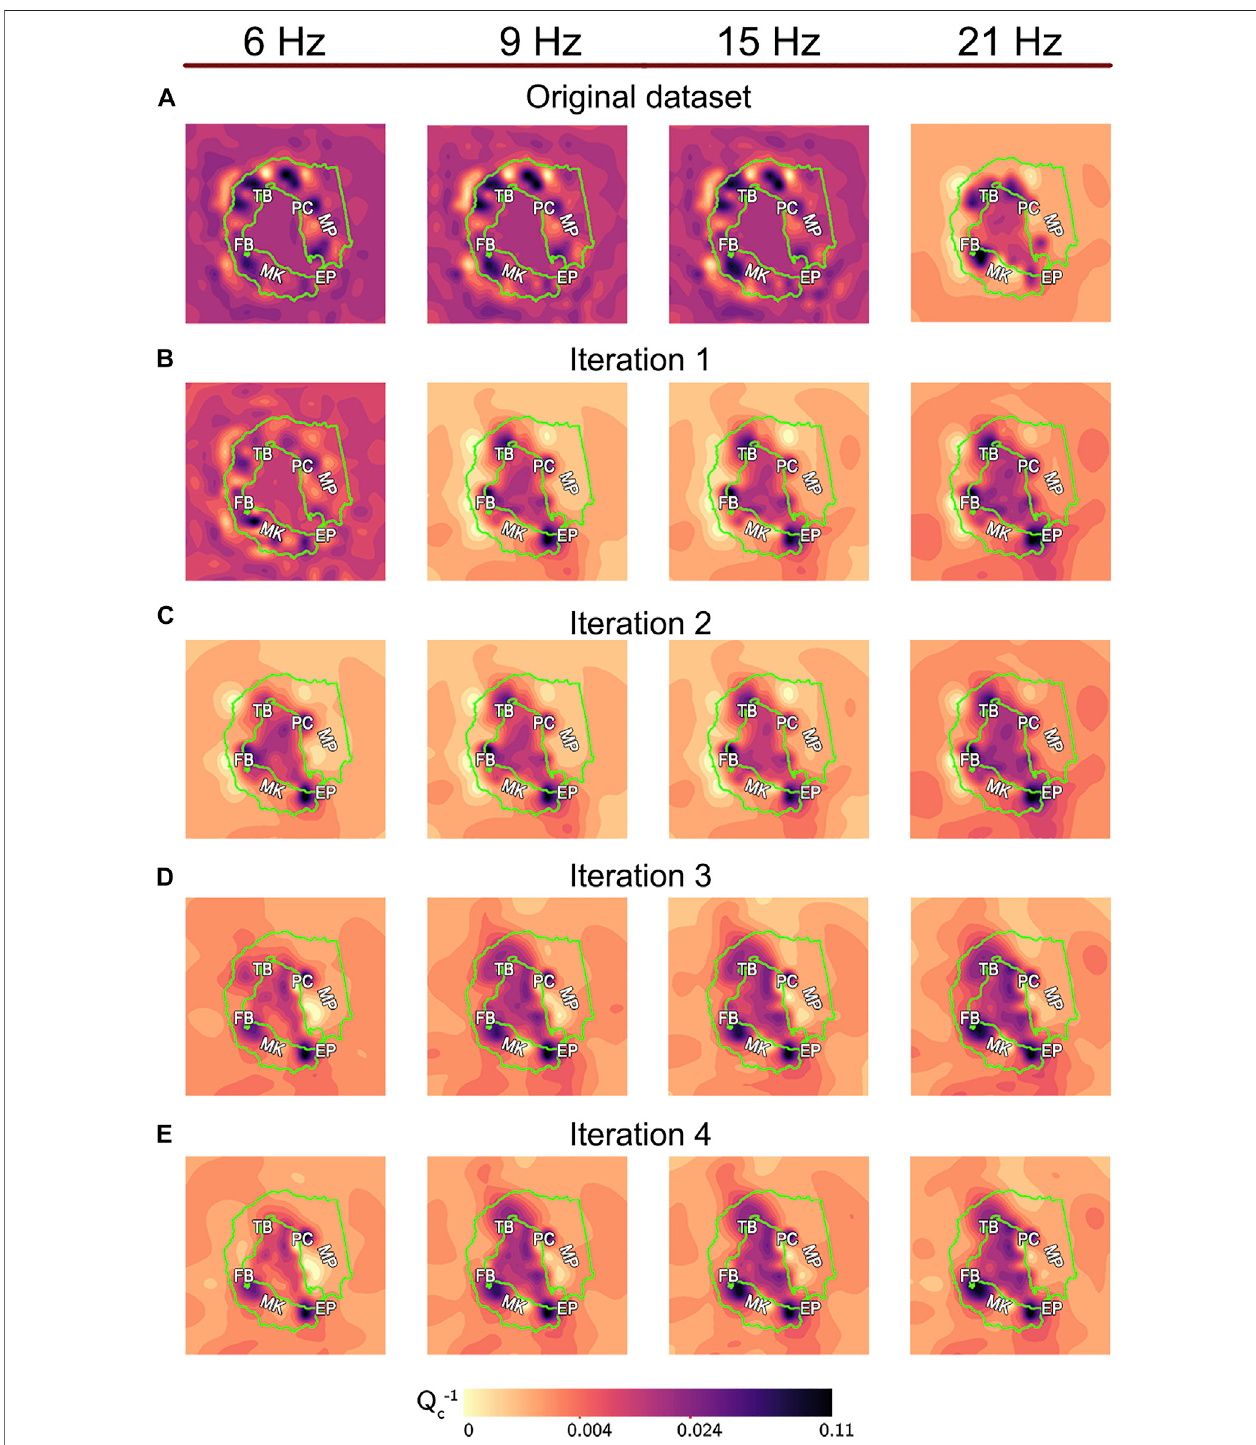
FIGURE 4 | Maps of coda attenuation ( Qc − 1 ) obtained with a node spacing of 2 km. Each panel corresponds to the results obtained with the original dataset (A) , 20283 traces) or after removing traces: (B) with an average percentage of zeros greater then 40% (14972 traces); (C) whose main peak amplitude was later than 6 s (13105 traces); (D) having a coda decay correlation coef fi cient lower than 0.6 (7895 traces); (E) at stations with instruments producing spikes (7197 traces). TB: Telephone Bay; PC: Pendulum Cove; MP: Mount Pond; EP: Entrance Point; MK: Mount Kirkwood; FB: Fumarole Bay.